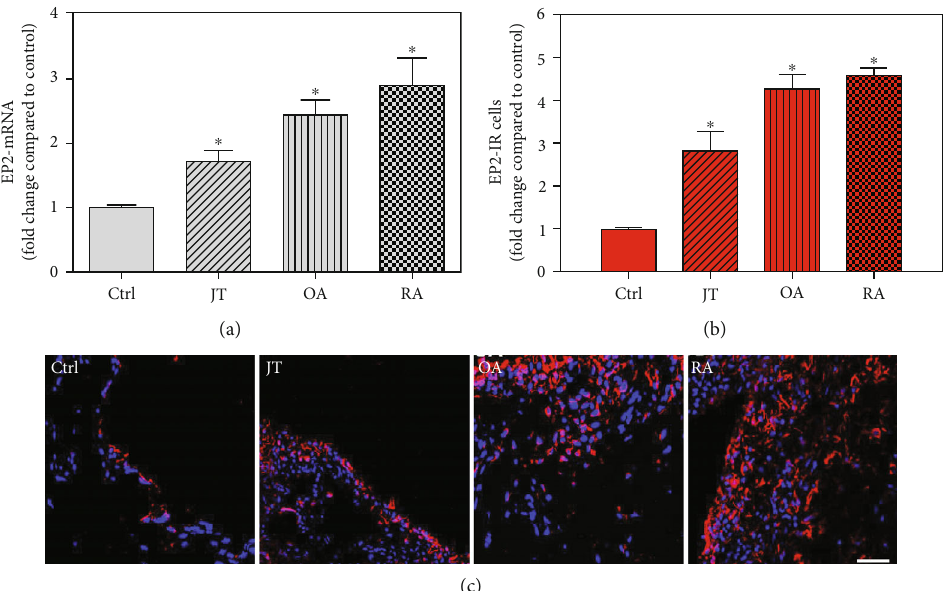
Figure 5: Detection of PGE-2 receptor 2 (EP2 receptor) mRNA (a) and number of EP2-IR cells (b, c) in patients with joint trauma (JT), osteoarthritis (OA), and rheumatoid arthritis (RA). (a) Quanti fi cation of EP2 mRNA shows that EP2 mRNA was signi fi cantly higher in JT, OA, and RA compared to control synovium (data are shown as means ± SEM , P < 0 : 05 , one-way ANOVA followed by Tukey ’ s test). (b) Quantitative analysis of immuno fl uorescence microscopy for EP2-IR cells relative to the control synovium (data are shown as means ± SEM , P < 0 : 05 , Kruskal – Wallis ANOVA on ranks followed by Dunn ’ s test). (c) Immuno fl uorescence microscopy shows more abundant EP2-IR cells (Texas red fl uorescence) in rheumatoid and osteoarthritic synovium compared to JT and control. DAPI blue fl uorescence shows nuclear staining. Bar = 20 μ m . ( ∗ P < 0 : 05 , compared to control).